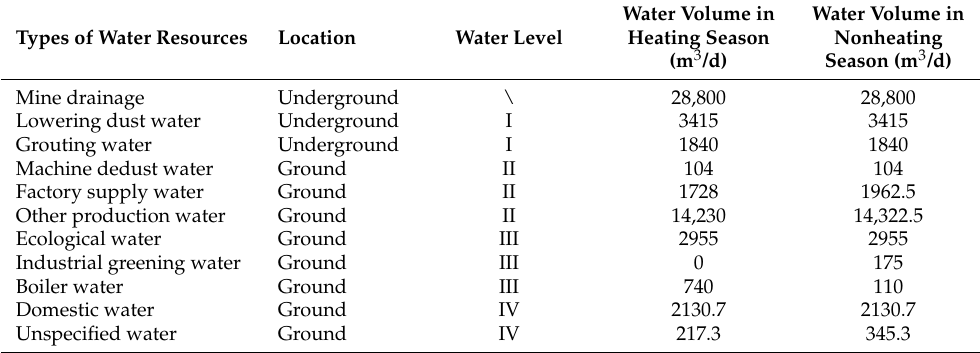
Table 3. Summary of water resource demand in the mining